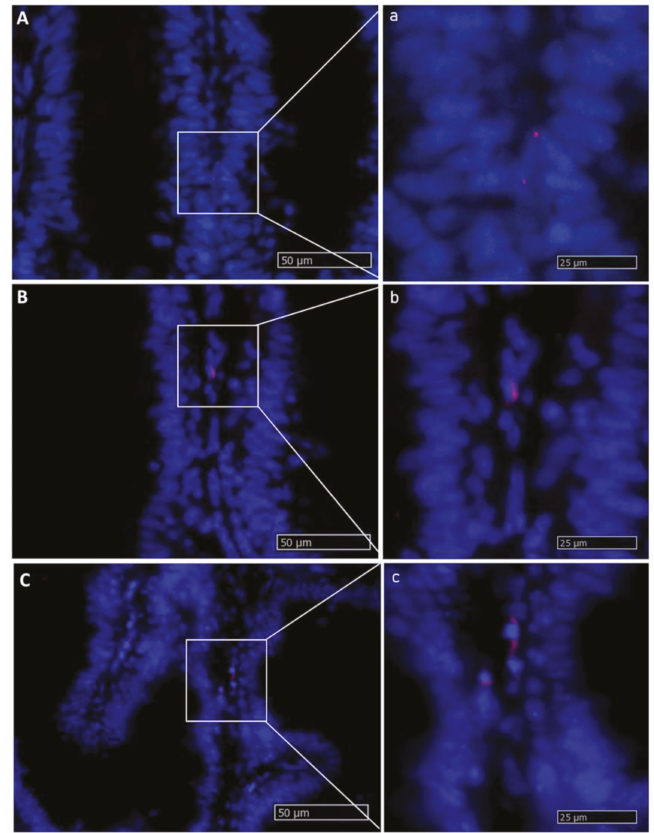
Figure 8. In situ hybridization of lgr5 messenger RNA (mRNA) in di ff erent segments of the rainbow trout mid-intestine (red dots). This gene was expressed at a low rate in the whole organ. The lowest expression level was observed in the first segment of the mid-intestine ( A , a ): higher magnification), and an intermediate signal was seen in the pyloric caeca ( B , b ): higher magnification), whereas the basal part of the complex folds and the rest of the second segment of the mid-intestine showed the highest signal ( C , c ): higher magnification).